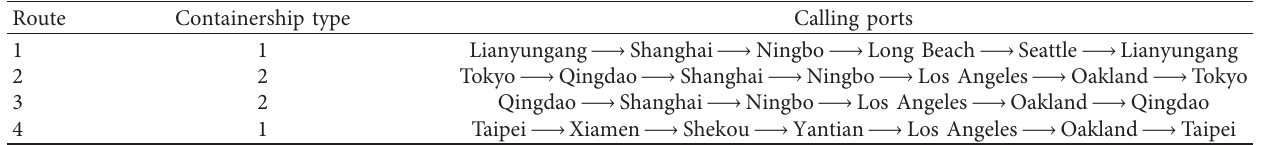
Table 1: East Asia-U.S. West coast liner shipping